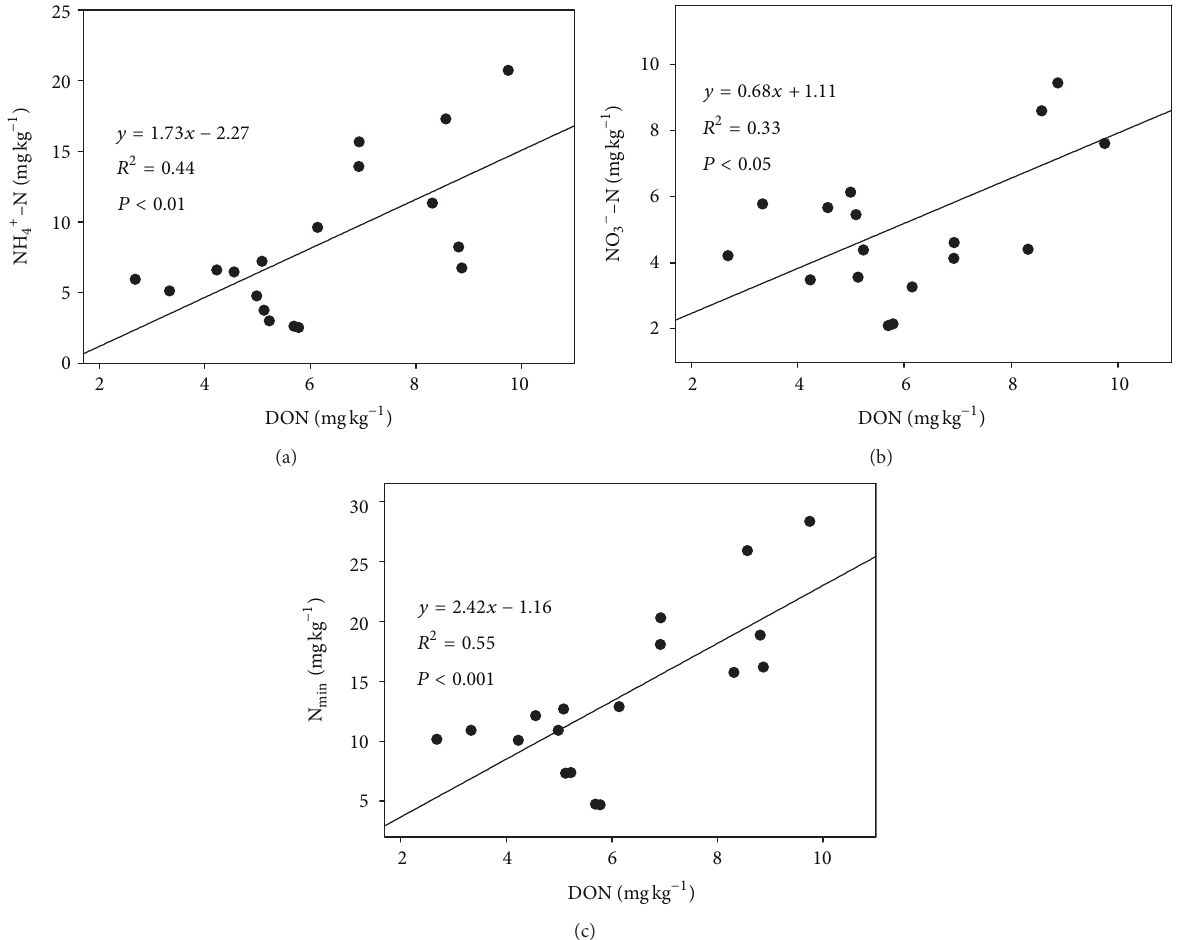
Figure 3: Relationships of dissolved organic N (DON) with ammonium N ( NH 4+ -N ) , nitrate N ( NO 3− -N ) , and soil inorganic N ( N min ) . ∘ an alpine meadow ( ∼ 3 C increase of 5 cm soil temperature) on the Tibetan Plateau [3], and in a temperate steppe with chestnut soil in Inner Mongolia ( ∼ 1.2 ∘ C increase of 10 cm soil temperature) [1]. Therefore, the insignificant responses of SOC, TN, DOC, and DON to warming (Table 1) may be due to the short period of warming treatment (14–16